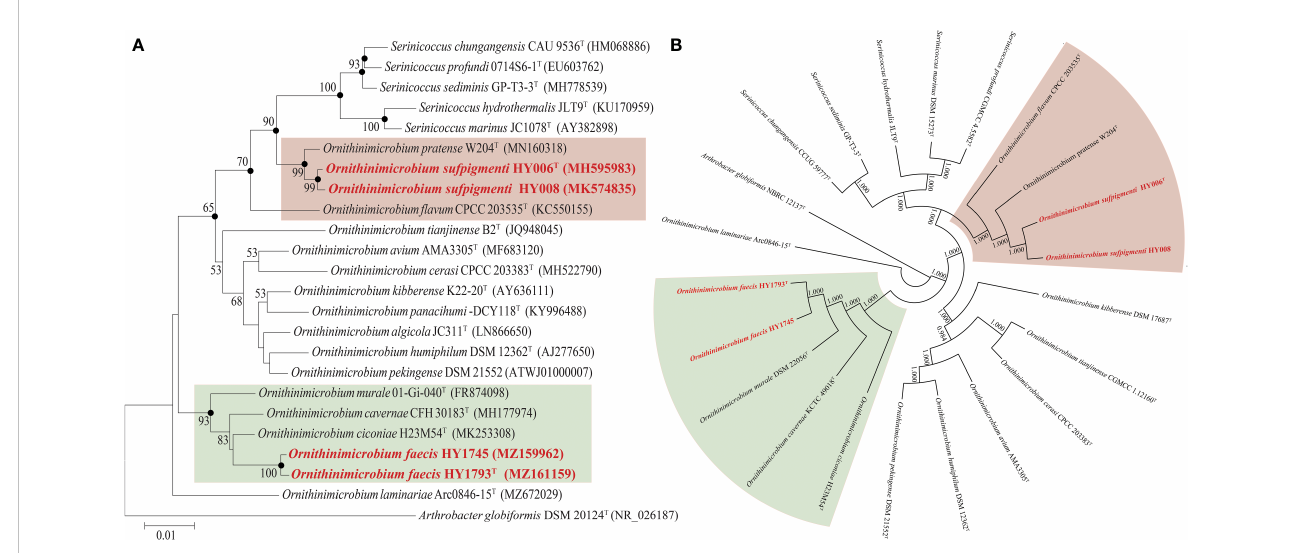
FIGURE 1 The phylogenetic (A) and phylogenomic tree (B) of O. sufpigmenti sp. nov., O. faecis sp. nov. and other species of family Ornithinimicrobiaceae . (A) Solid circles indicate the nodes supported by maximum-likelihood and maximum-parsimony analyses. Numbers on the tree indicate bootstrap values calculated for 1000 subsets for branch points >50%. Bar, 0.01 substitutions per nucleotide position. (B) Numbers on the tree indicate each split in the tree support values with the Shimodaira-Hasegawa test calculated for 1000